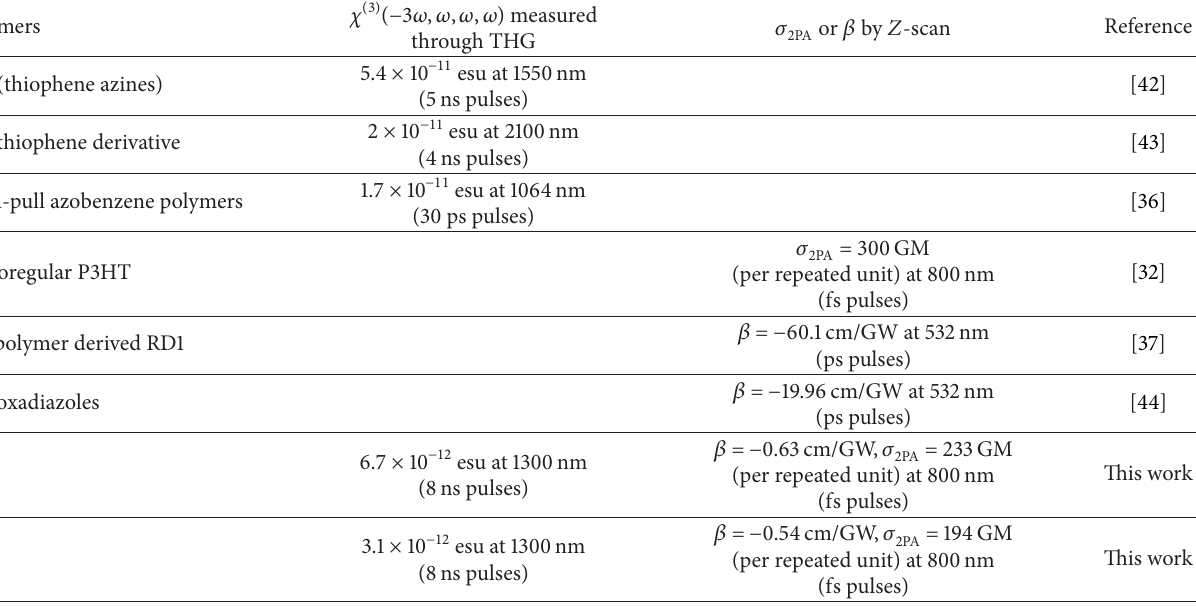
or 𝛽 values obtained by 𝑍 -scan technique. 2PA